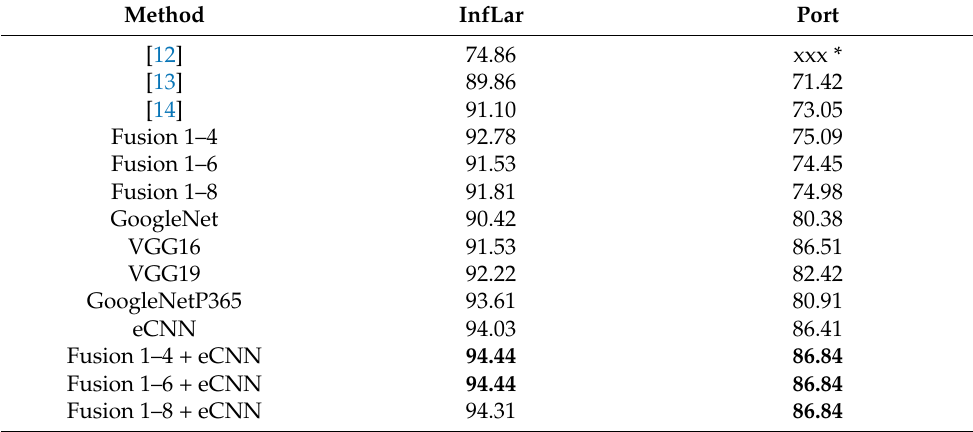
Table 3. Performance accuracy obtained considering different standard CNNs and other Siamese approaches (xxx * means that it does not converge, and boldface represents best